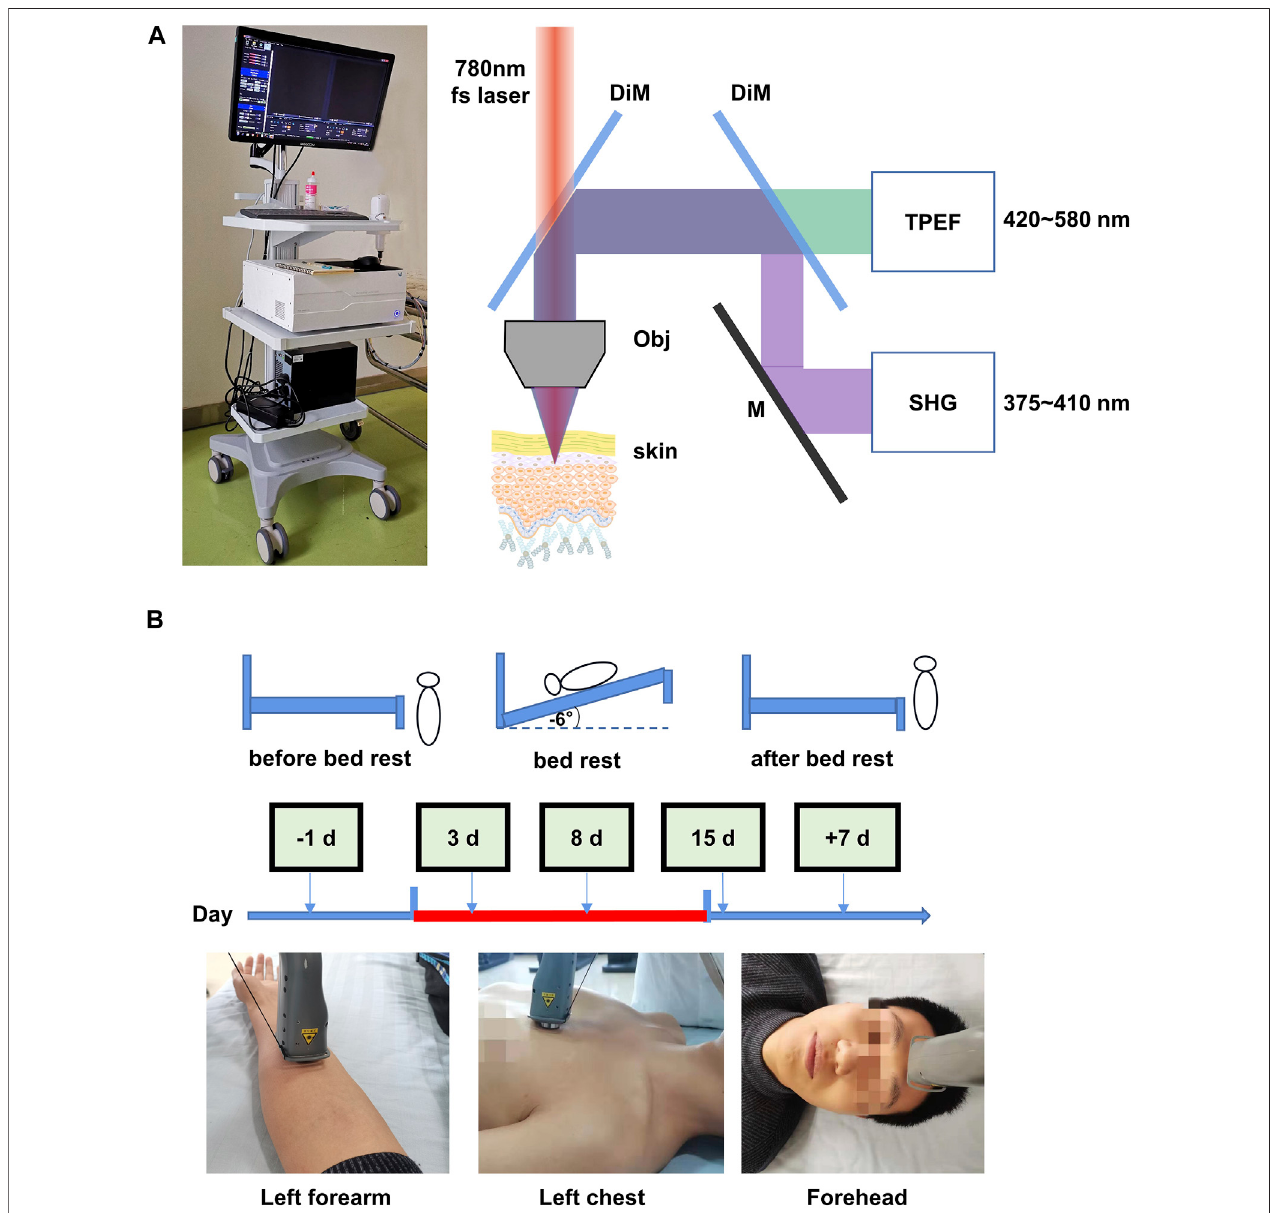
FIGURE 1 | Optical biopsy of in situ human skin during 15 days of head-down bed rest. (A) Corresponding two-photon excited fl uorescence (TPEF) and second harmonic generation (SHG) fi tted images of the skin obtained from different depths below the skin surface, as shown in the images. (B) Measurement schedule. The indicated measurements were performed at each time